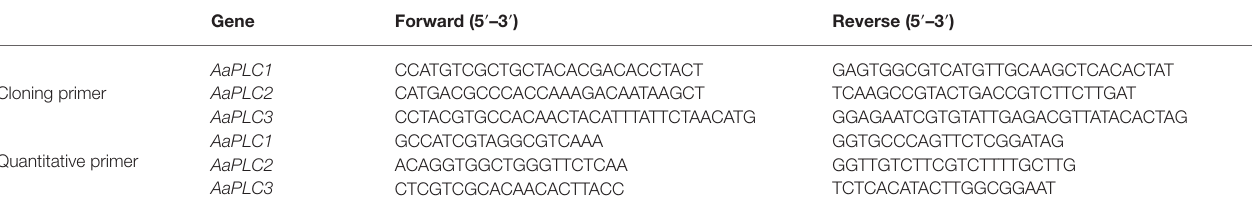
TABLE 2 | Primers used in the